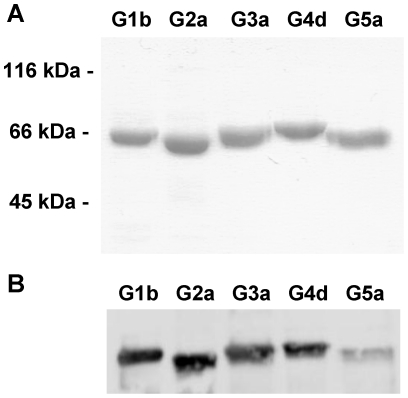
Purification of NS5BΔ21 proteins by affinity chormatography and cationic exchange.A) Purified proteins after cationic exchange chromatography (heparin-sepharose column) eluted at 500 mM NaCl and detected with Coomassie blue staining. B) Western blot detection of HCV NS5B genotypes 1 to 5 with a polyclonal antibody. Protein molecular weigth markers (in kilodaltons) are shown on the left.